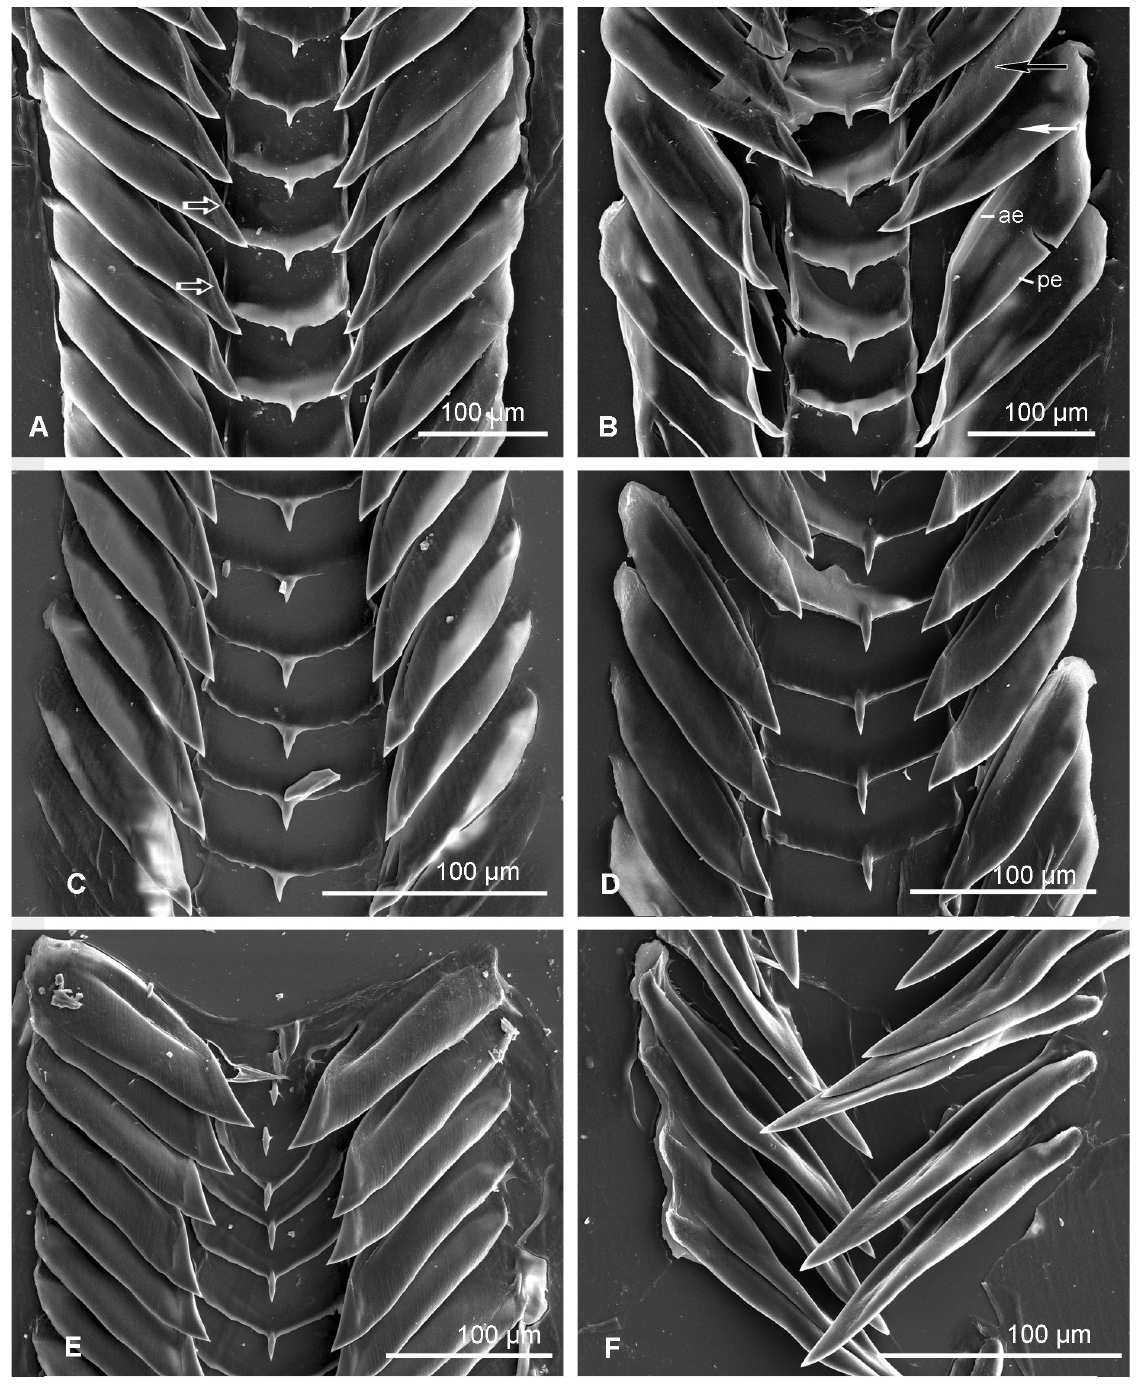
Fig. 8. Radulae of species of Sibogasyrinx Powell, 1969. A–B . Sibogasyrinx sangeri Kantor, Fedosov & Puillandre, 2018, MNHN-IM-2009-16995 (shell seen on Fig. 7C). A . Part of radula with fully formed marginal teeth; white hollow arrow indicates overlapping edges of the tooth at its tip. B . Part of radula showing transition between unfolded (white arrow) and completely longitudinally folded (black arrow) marginal teeth (ae = anterior tooth edge; pe = posterior tooth edge). C . Sibogasyrinx filosa Ardovini, 2021, Solomon Islands, MNHN-IM-2009-16831 (shell seen Fig. 9E–F). D . Sibogasyrinx lolae sp. nov., MNHN-IM-2009-29311. E . Sibogasyrinx maximei sp. nov., holotype, MNHN-IM-2013-45883, anterior end of radula. F . Sibogasyrinx pagodiformis sp. nov.,